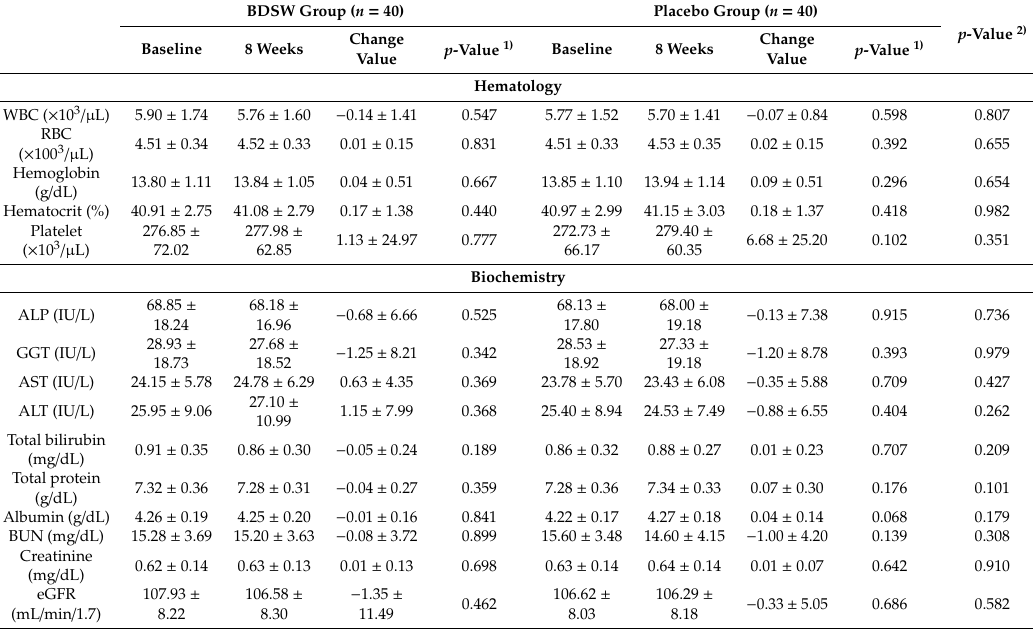
Table 8. Laboratory medicinal